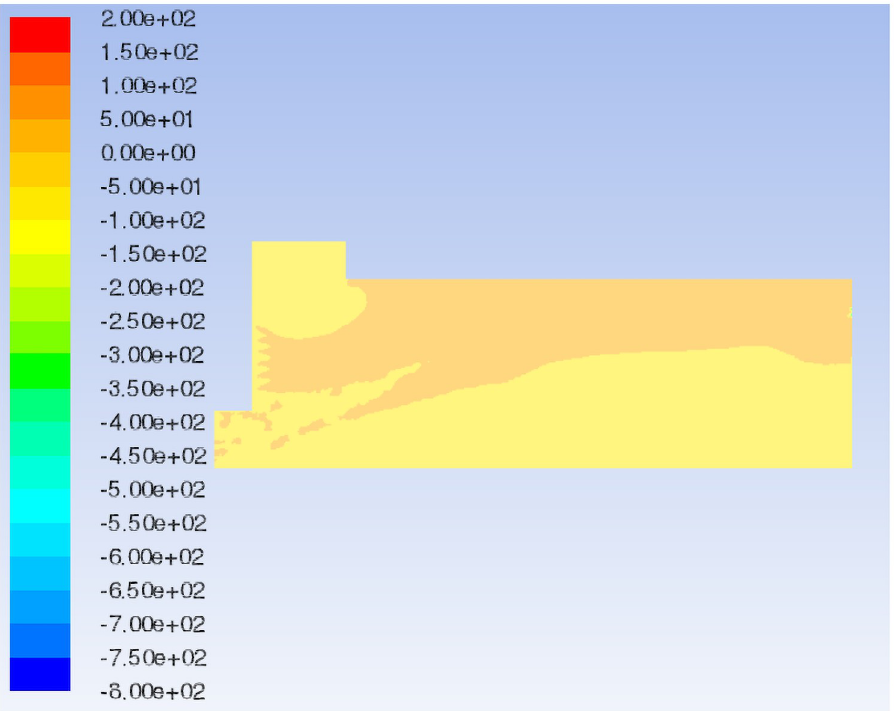
Fig 17. Flow field total pressure distribution of Model